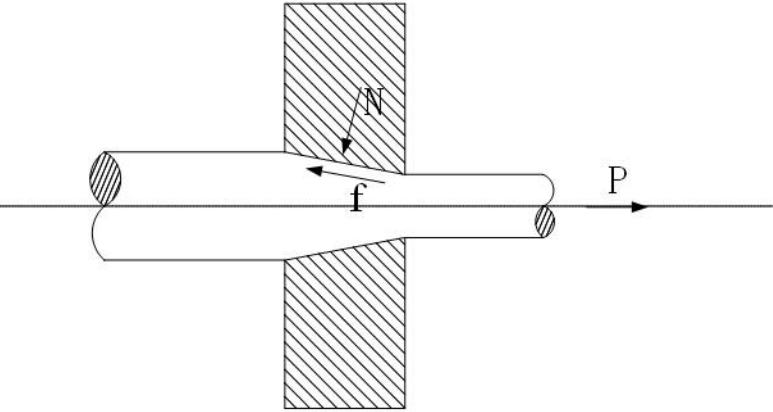
Figure 7. Schematic diagram of the force of the drawing process (N: pressure, P: drawing force, f: friction).